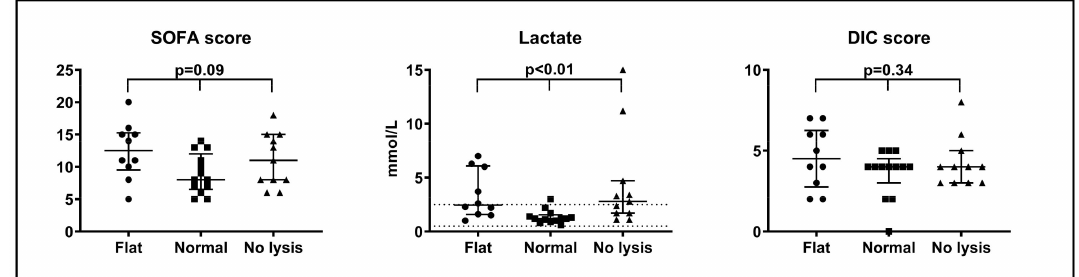
Figure 3. Sequential Organ Failure Assessment (SOFA) score, arterial blood lactate and disseminated intravascular coagulation (DIC) score in patients with flat, normal and lysis-resistant fibrin formation and lysis